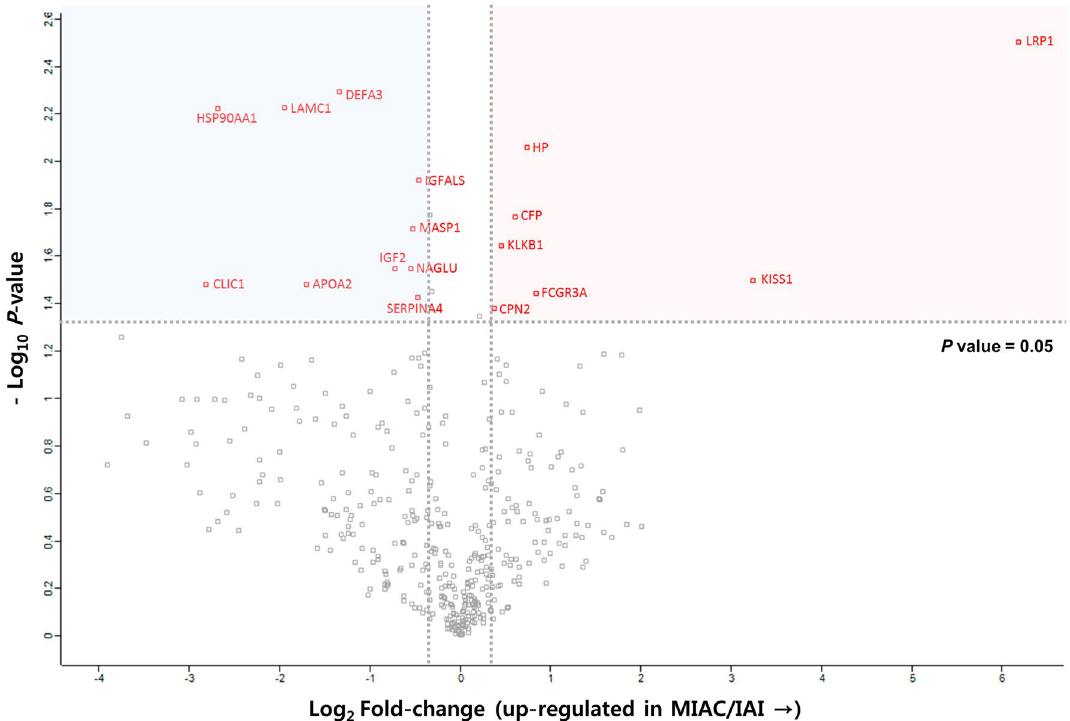
Figure 2. Label-free quantification proteomic data of DEPs in MIAC/IAI case vs . non-MIAC/IAI control. Representative protein identifiers in red indicate statistically significant DEPs with P < 0.05 and fold change of